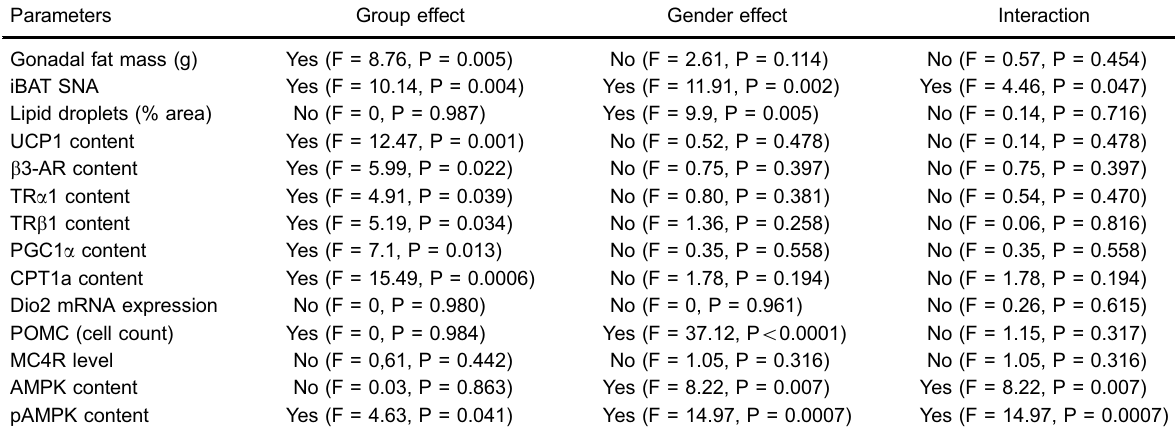
Table 1. Long-term effects of neonatal cigarette smoke exposure on all analyzed parameters in 180 postnatal day offspring. Parameters